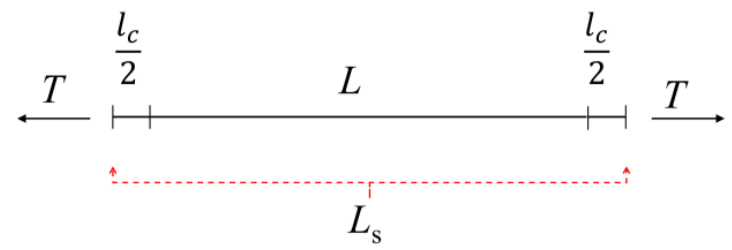
Figure 4. Axial tensile deformation of SMA cable.